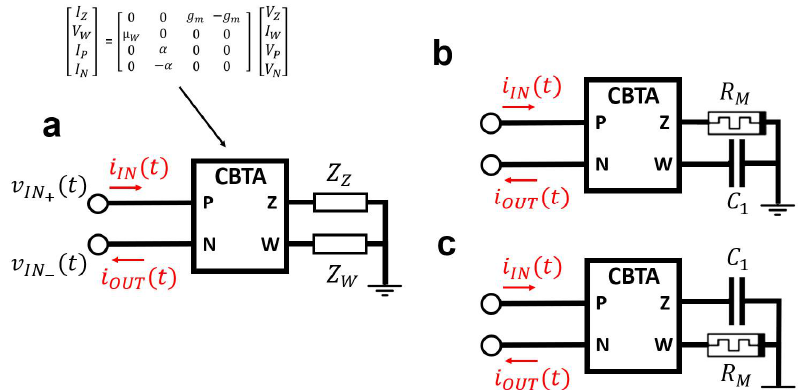
Figure 17. ( a ) CBTA-based circuit for the emulation of floating memcapacitors and meminductors devices proposed by Taşkiran et al. [60]. ( b ) Mutator for the emulation of memcapacitors, ( c ) mutator for the emulation of meminductors.